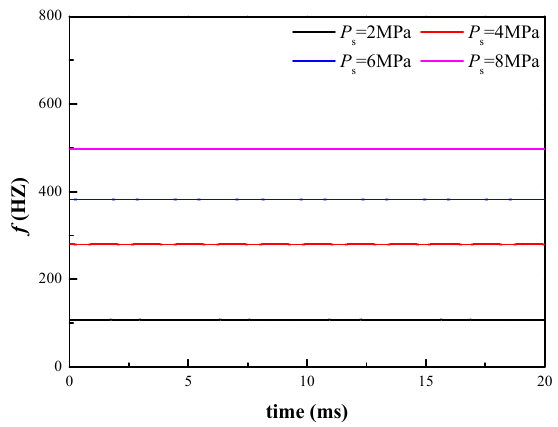
Figure 15. Accelerations of different supply pressures.